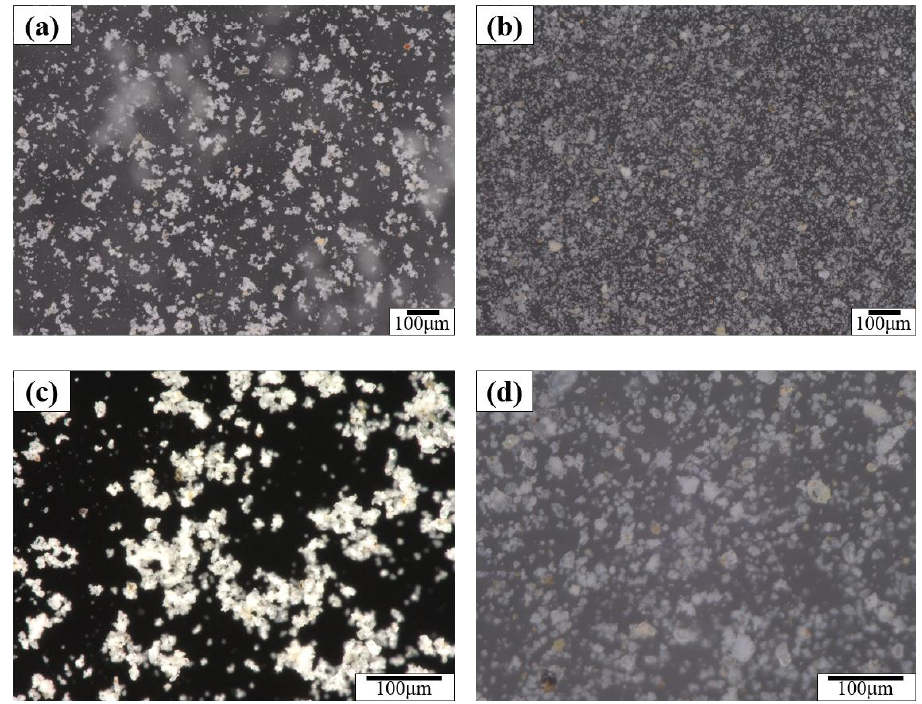
Figure 8. Optical microscopy images of NHL suspensions: ( a , c ) 0 wt% IBMA; ( b , d ) 0.6 wt% IBMA.